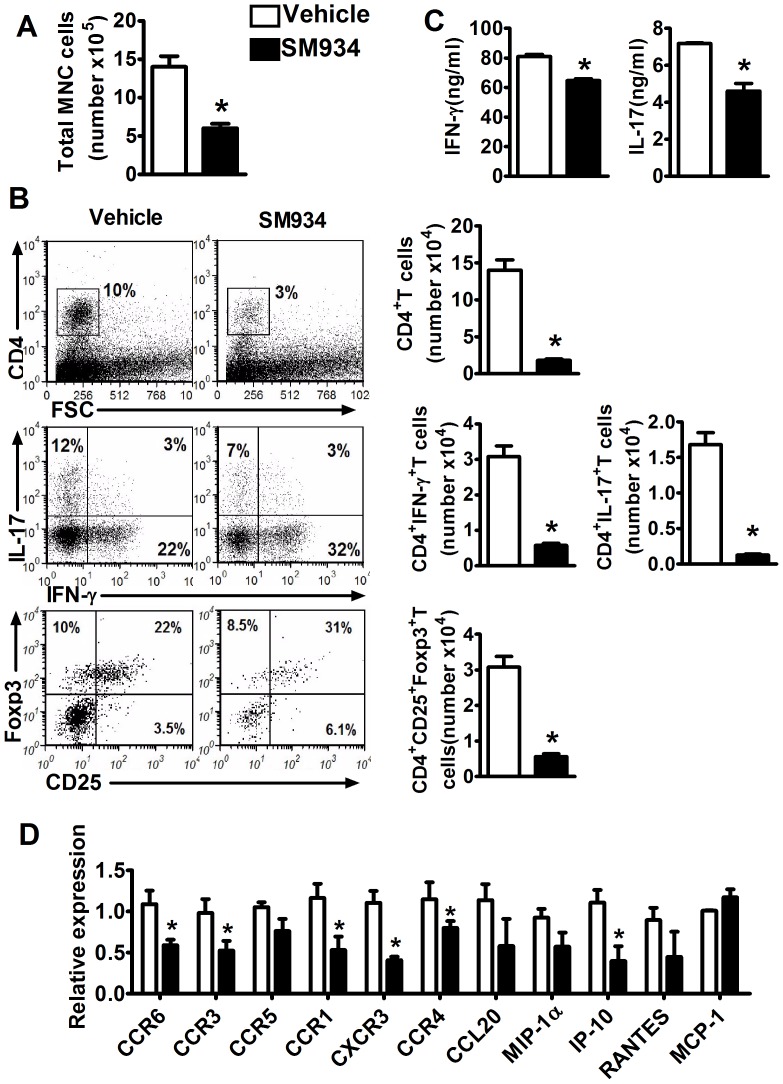
SM934 reduced encephalitogenic cells infiltrating into the CNS.Spinal cord were detached from EAE mice at the peak of disease (day 18), infiltrated mononuclear cells were isolated by density gradient centrifugation, (A) cell number were counted, (B) intracellular IFN-γ, IL-17 and Foxp3 in the CD4+ T cells were analyzed by flow cytometry, absolute number of CD4+IFN-γ+, CD4+IL-17+, CD4+CD25+Foxp3+ cells were calculated. (C) Isolated MNC were stimulated with IL-12 (20 ng/ml) or IL-23 (20 ng/ml) for 72 hours, supernatants were collected to measure IFN-γ and IL-17 levels, respectively. (D) Spinal cord were isolated and analyzed by real-time PCR for expression of indicated chemokines and receptors. Results were expressed as mean ± SEM. *, p<0.05 compared with vehicle control. Three independent experiments were performed with similar results.